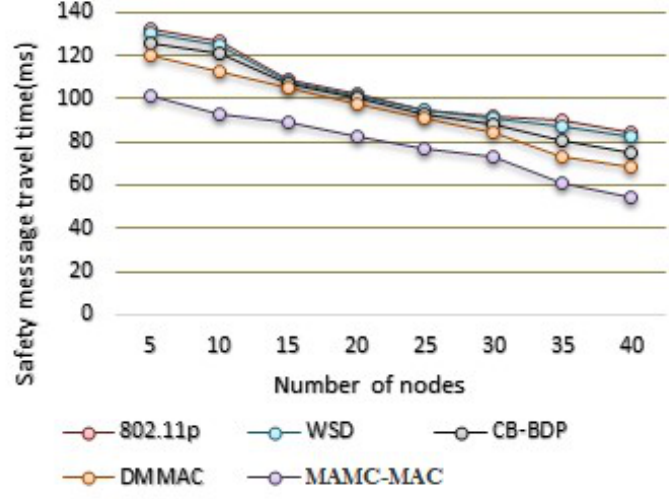
Figure 12. Message travel time